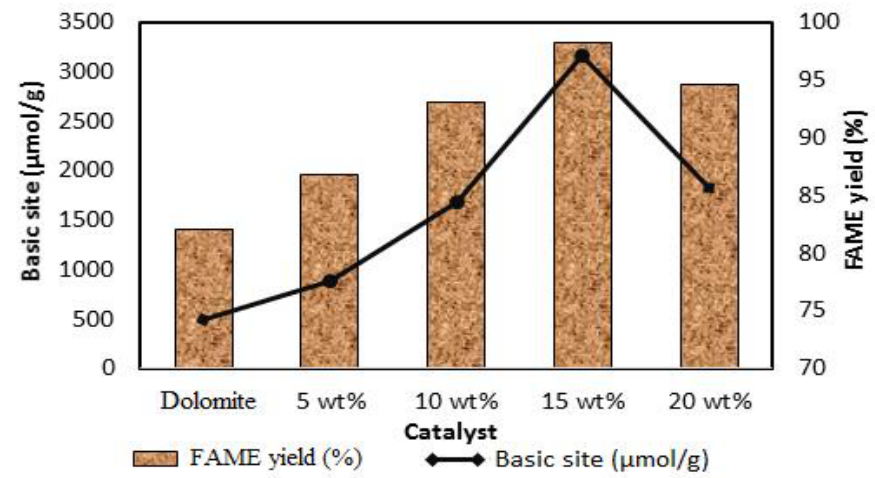
Figure 10. Correlation between FAME yield, basic strength and catalyst loading.